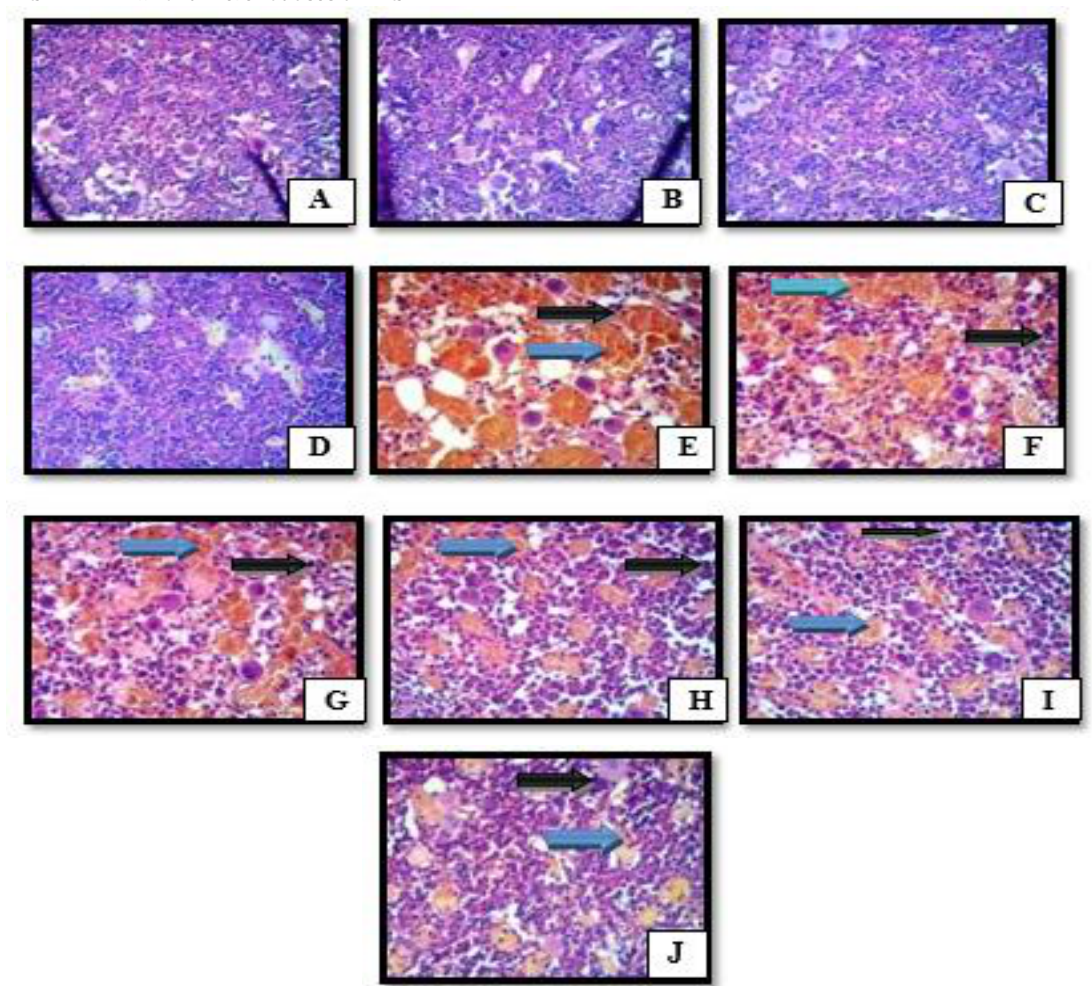
Figure 1. Histopathological section of bone marrow in various experimental rats' groups; (Hematoxylin and eosin;